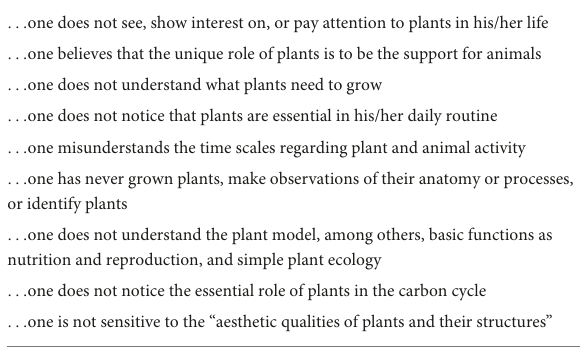
TABLE 1 Indicators for plant blindness as defined by Wandersee and Schussler (1999). One may suffer from plant blindness when .